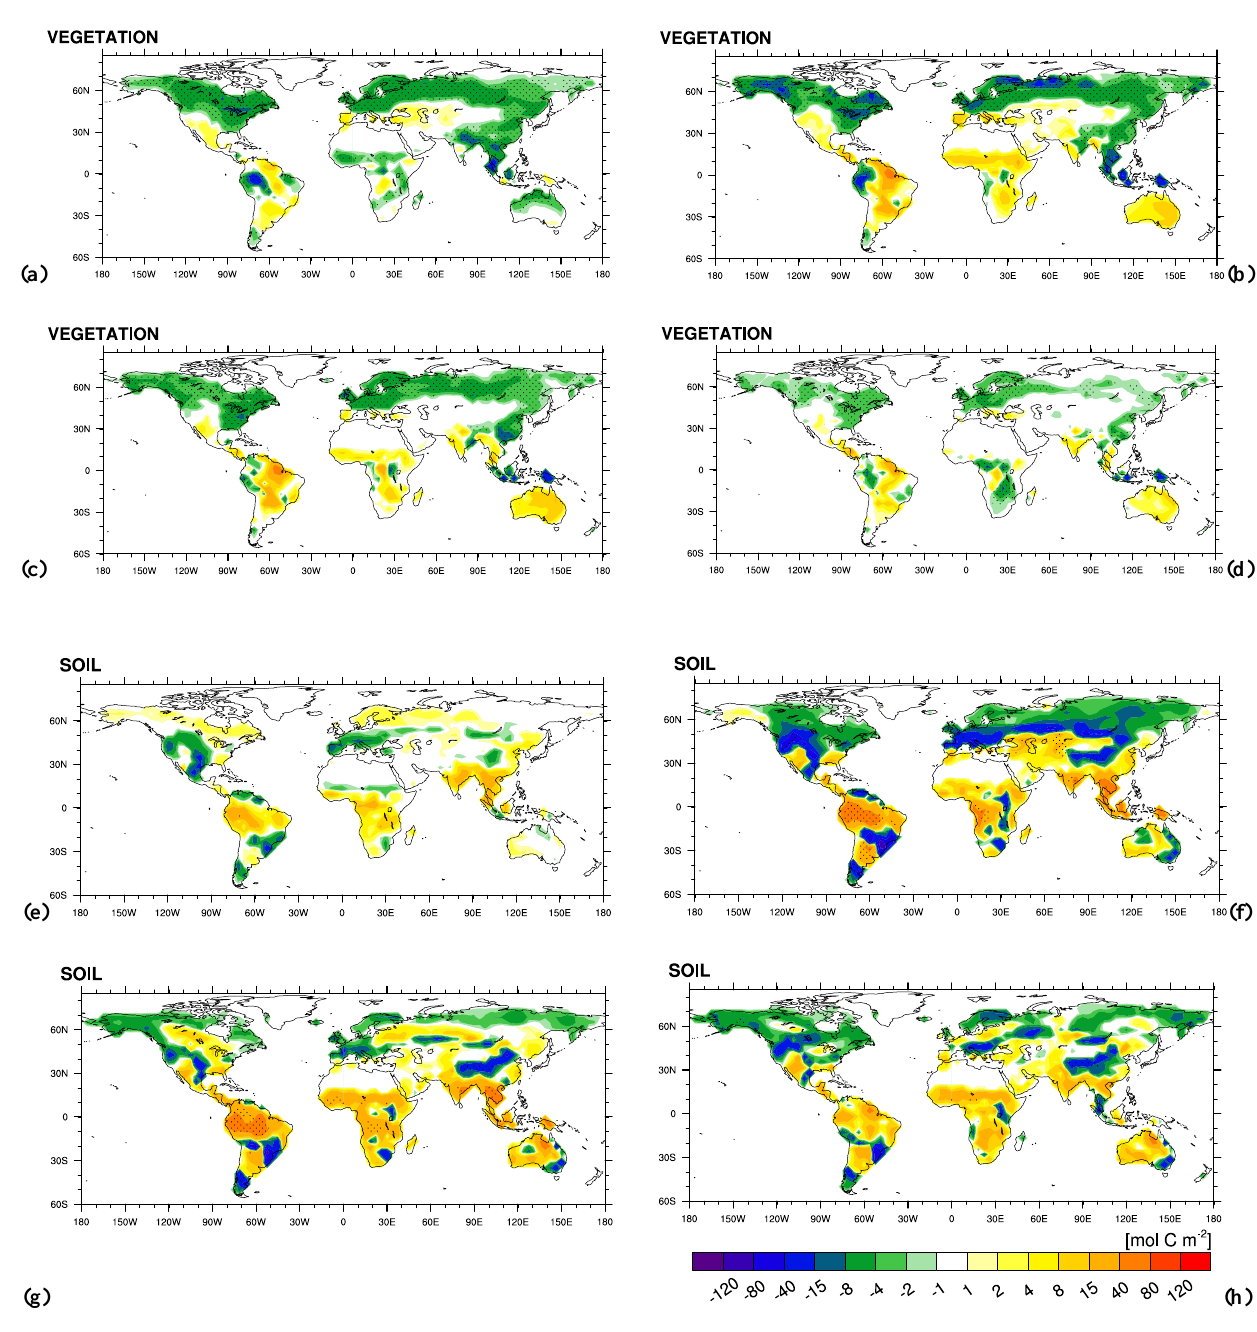
Fig. 14. Maps of ensemble mean land carbon pool anomalies. (a–d) : vegetation; (e–h) : soil. Annual average in [molCm − 2 ] for (a, e) Year 2, (b, f) Year 5, (c, g) Year 50 and (d, h) Year 200 of the experiment. Stippled areas indicate significance of anomalies based on the 2- σ